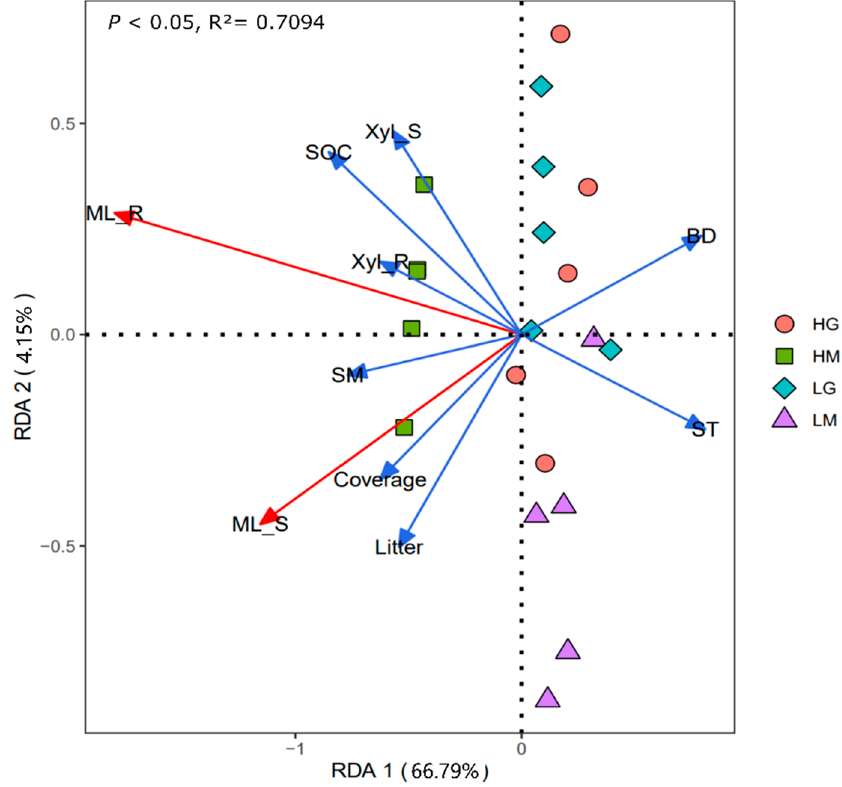
Figure 4. Redundancy analysis graph of the relationships between the plant and soil properties and mass loss of shoot and root ( p < 0.05). Litter: litter biomass; ST: Soil temperature; SM: Soil moisture; BD: bulk density; SOC: soil organic carbon; Xyl_L: β -xylosidase of shoot; Xyl_R: β -xylosidase of root. HG: high altitude + grazing; HM: high altitude + mowing; LG: low altitude + grazing; LM: low altitude + mowing.